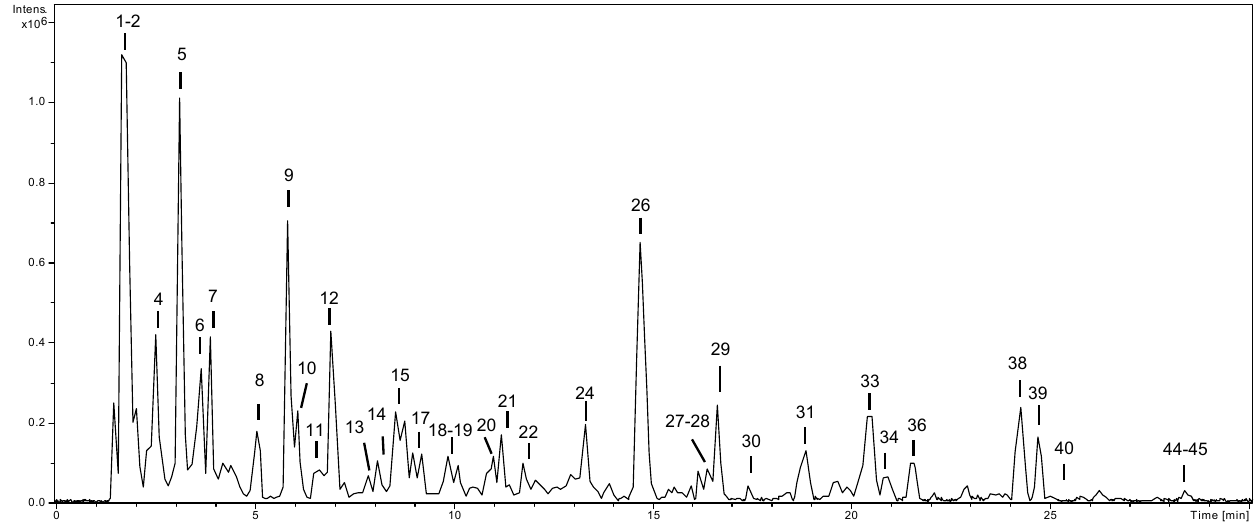
Figure 2. HPLC-ESI/MS n base peak chromatograms (BPC) of dealcoholized wine. Compounds 3 and 9 , with [M-H] − at m / z 311 and fragment ions at m / z 179 and 135 (typical of caffeic acid), were tentatively characterized as caftaric acid isomers, previously described in wine samples [36] (MS data are in Table S1, see supplementary material).